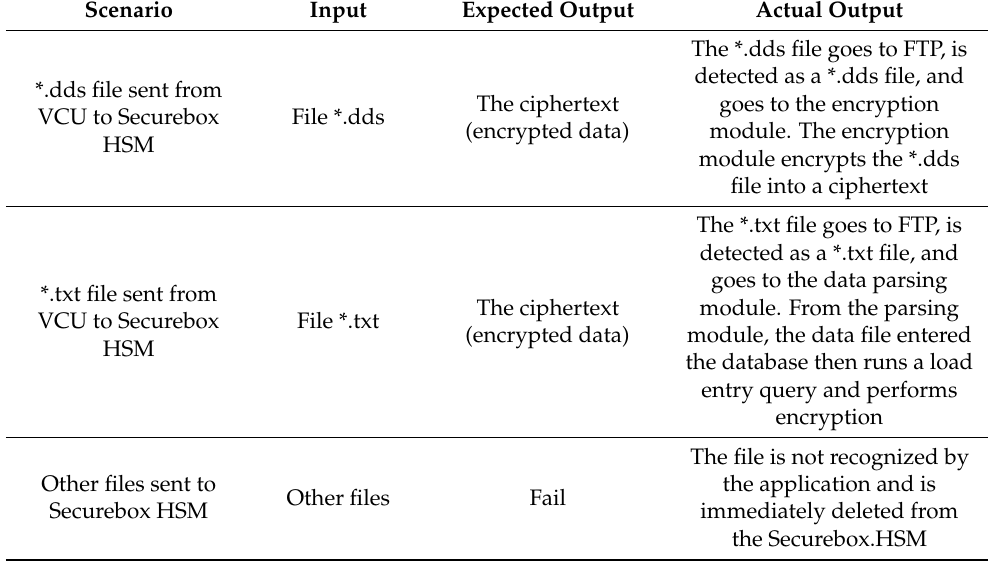
Table 6. Securebox HSM FTP server